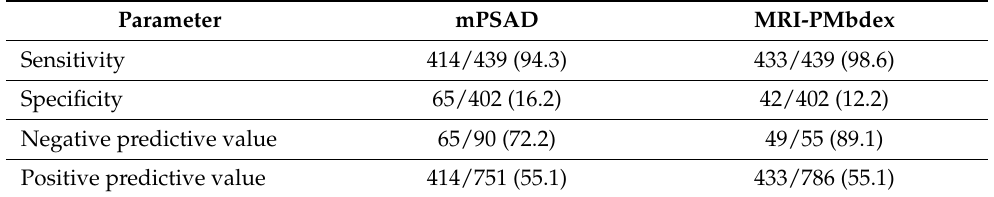
Table 6. Performance of mPSAD and MRI-PMbdex, with respective thresholds of 0.628 ng/mL 2 and 13.5%, in men with PI-RADS